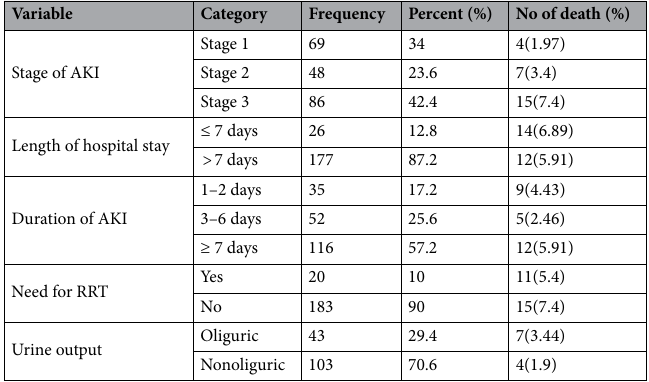
Table 3. Clinical characteristics of AKI patients at JMC (n = 203). JMC, Jimma Medical Center; AKI, acute kidney injury; RRT, renal replacement therapy.